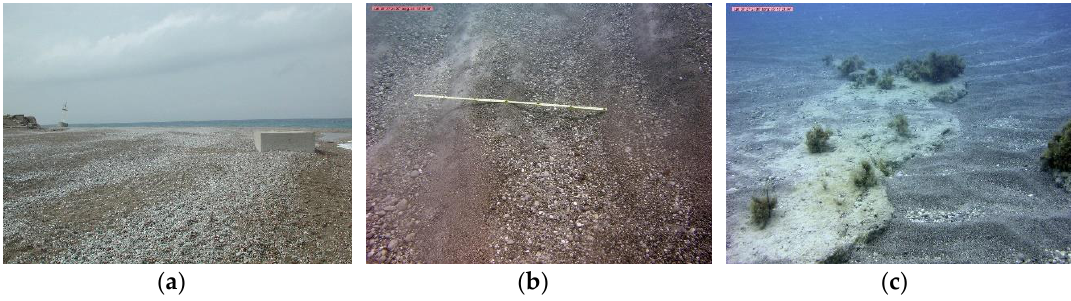
Figure 2. Photographs showing the texture of surface sediment on ( a ) the subaerial beach, ( b ) the foreshore, and ( c ) shoreface.